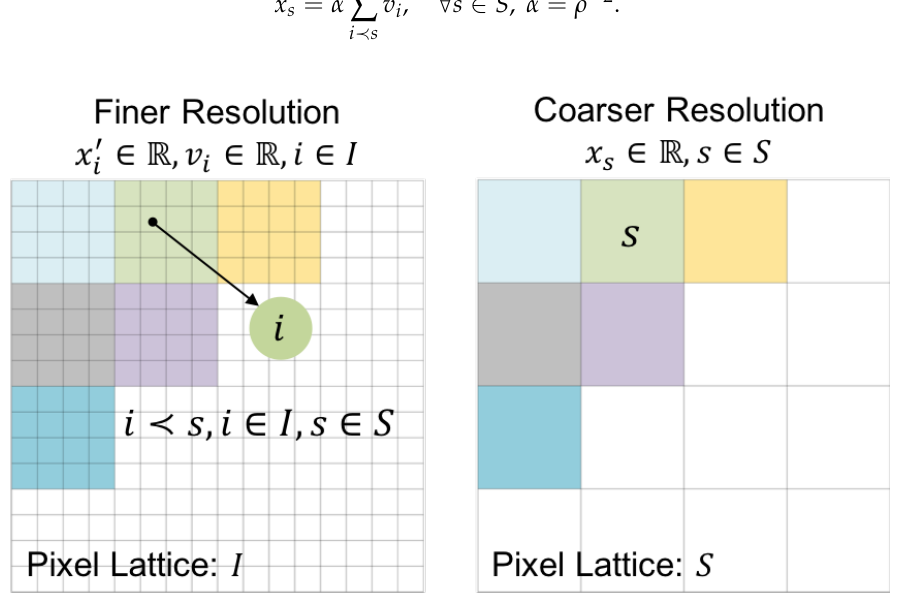
Figure 1. The pixel s belonging to the coarser resolution lattice S corresponds to a set of pixels i in the finer resolution lattice I . In the case of coarser resolution observations and virtual features, the two quantities are related through a linear mixture. In this example, the linear resolution ratio is ρ =